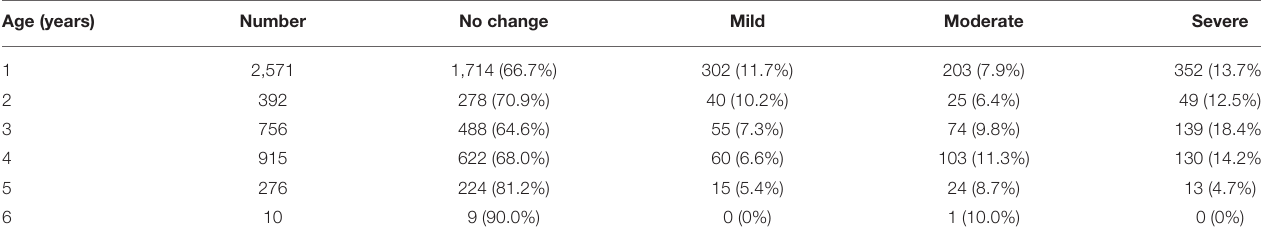
TABLE 4 | Classification of the degree of shift of myopia in preschool children aged from 1 to